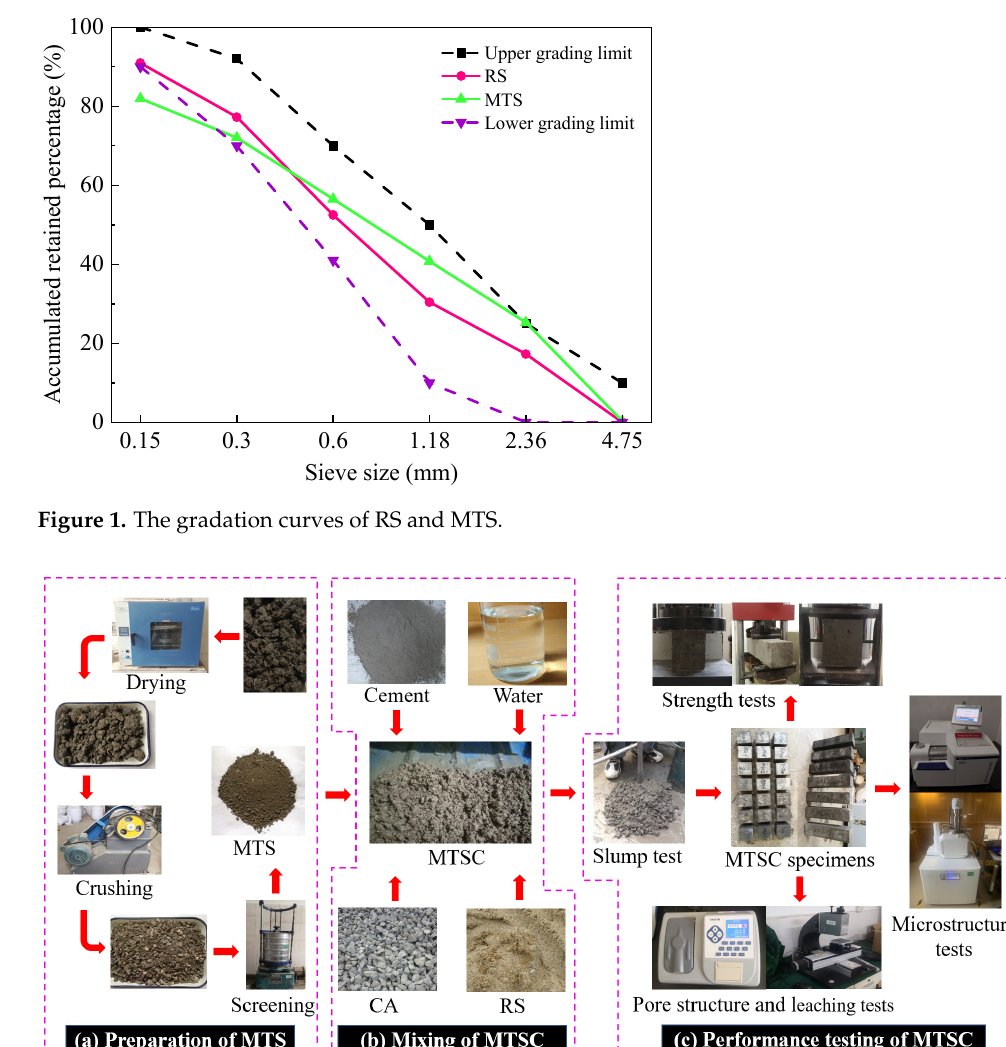
Figure 2. Test process diagram. ( a ) Preparation of MTS, ( b ) Mixing of MTSC, ( c ) Performance testing of MTSC.